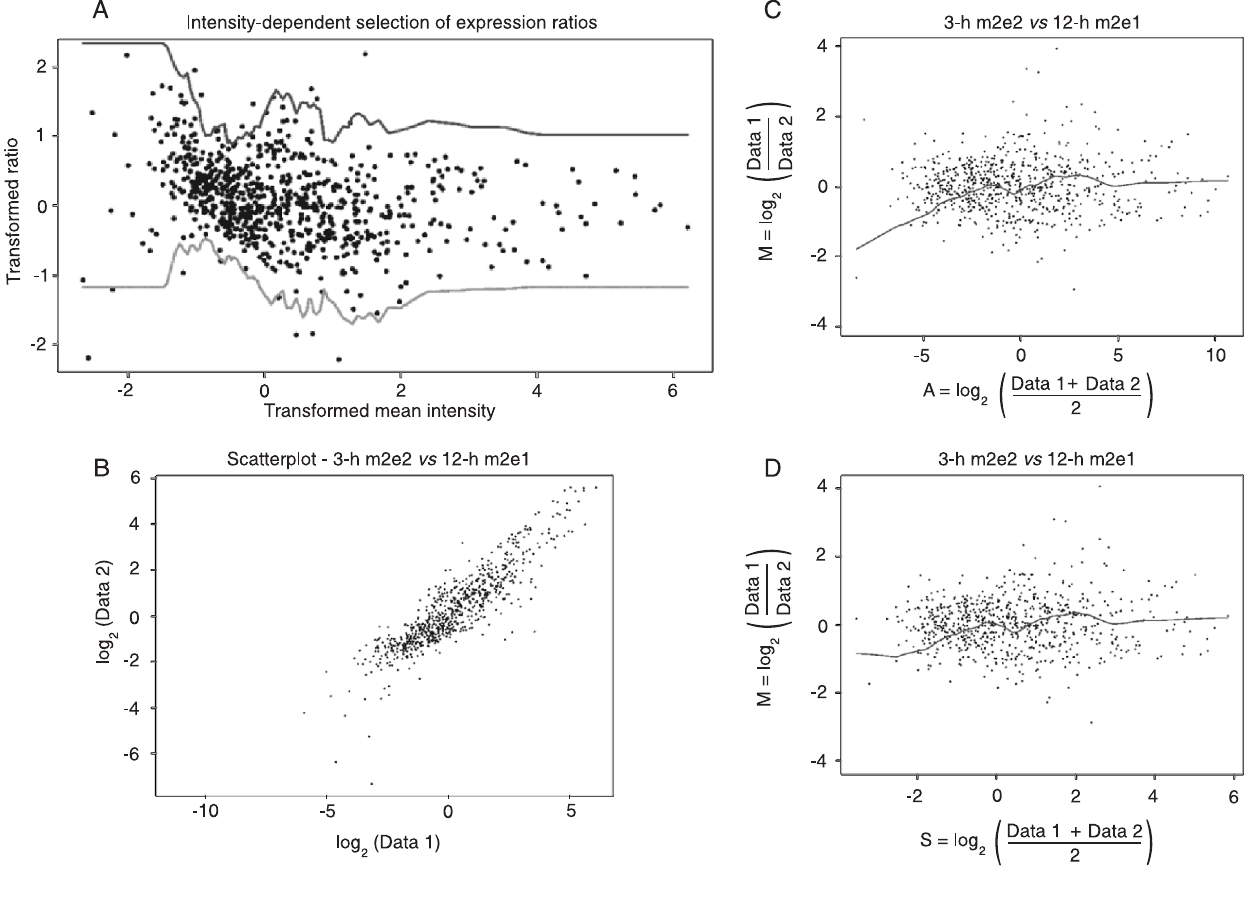
Figure 2. Data analysis with the pipeline for macro- and microarray analyses. Hybridization with RNA from sugarcane plants exposed to cold stress for 3 and 12 h. A , Intensity-dependent selection of expression ratios graphic output displaying the selection of differentially expressed genes, between 3 (Data 1) and 12 h (Data 2), based on the data variability dependence of intensities. B , Scatterplot displaying the log 2 normalized data. C and D , MA- and MS-plots with lowess correction. m2e1 and m2e2 codes indicate the membrane (m) and experiment (e) numbers defined by the